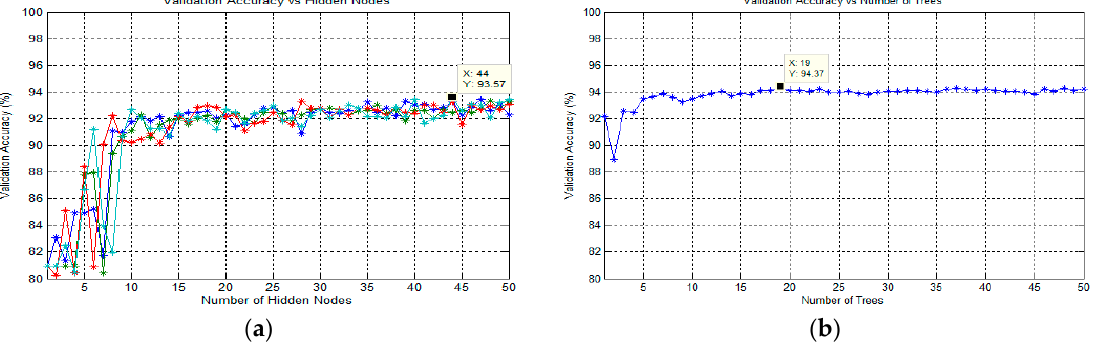
Figure 11. Analysis for classification between the malaria parasite and non-malaria parasite: ( a ) OS-ELM; ( b ) Random forest.